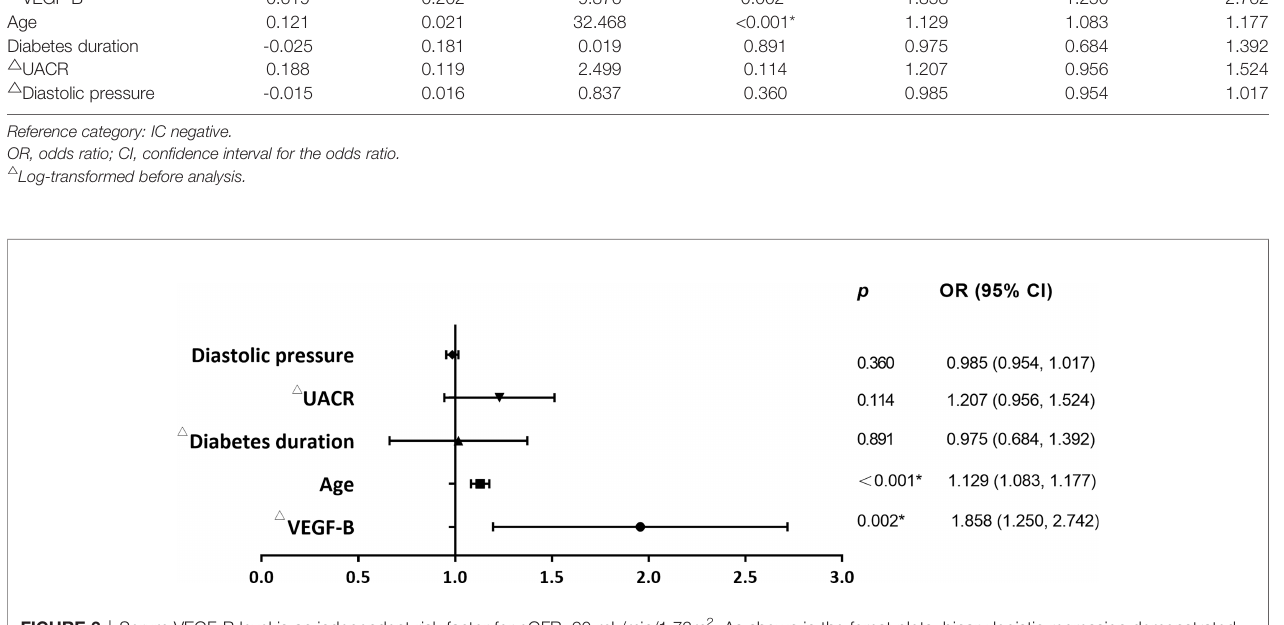
FIGURE 3 | Serum VEGF-B level is an independent risk factor for eGFR<90 mL/min/1.73m 2 . As shown in the forest plots, binary logistic regression demonstrated that serum VEGF-B level and age are independent risk factors for eGFR<90 mL/min/1.73m 2 . *Signi fi cance, p <0.05. △ Log-transformed before analysis.